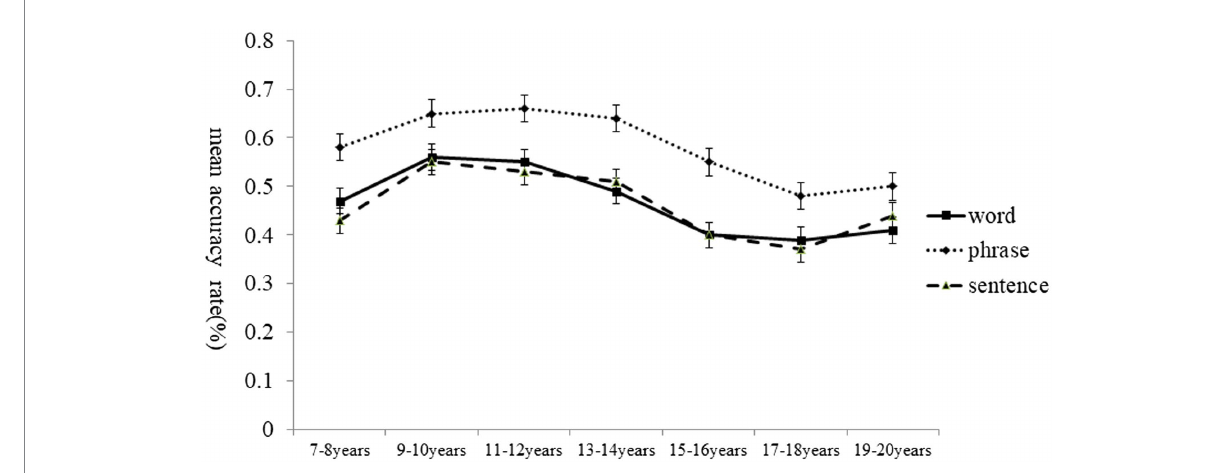
FIGURE 2 Mean accuracy rates of speechreading in Chinese as a function of age group and linguistic level.